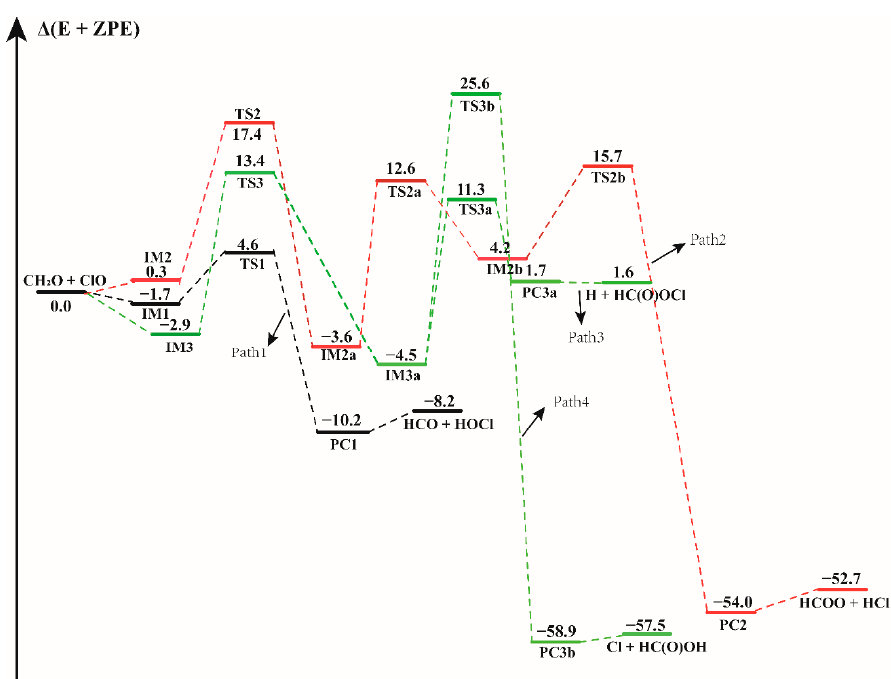
Figure 1. The energy profile of the CH 2 O + ClO water-free reaction. Energies (in kcal mol − 1 ) are calculated at the CCSD(T)/aug-cc-pVTZ//B3LYP-D3/aug-cc-pVTZ level.